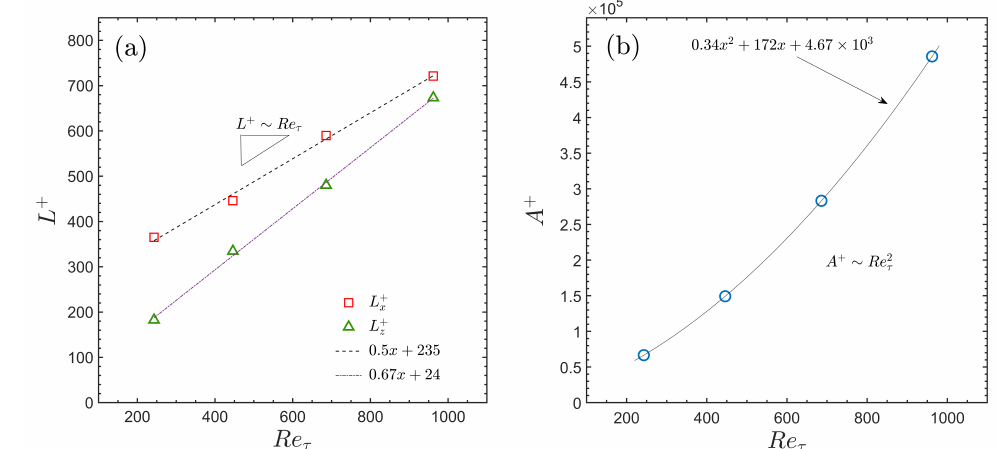
Figure 1. ( a ) The maximum streamwise and spanwise wavelengths for minimal flow units as functions of Reynolds number. Lines correspond to a linear fit. ( b ) Corresponding area A + = L + x × L + z for each MFU as a function of Reynolds number. As expected, the solid line corresponds to a quadratic